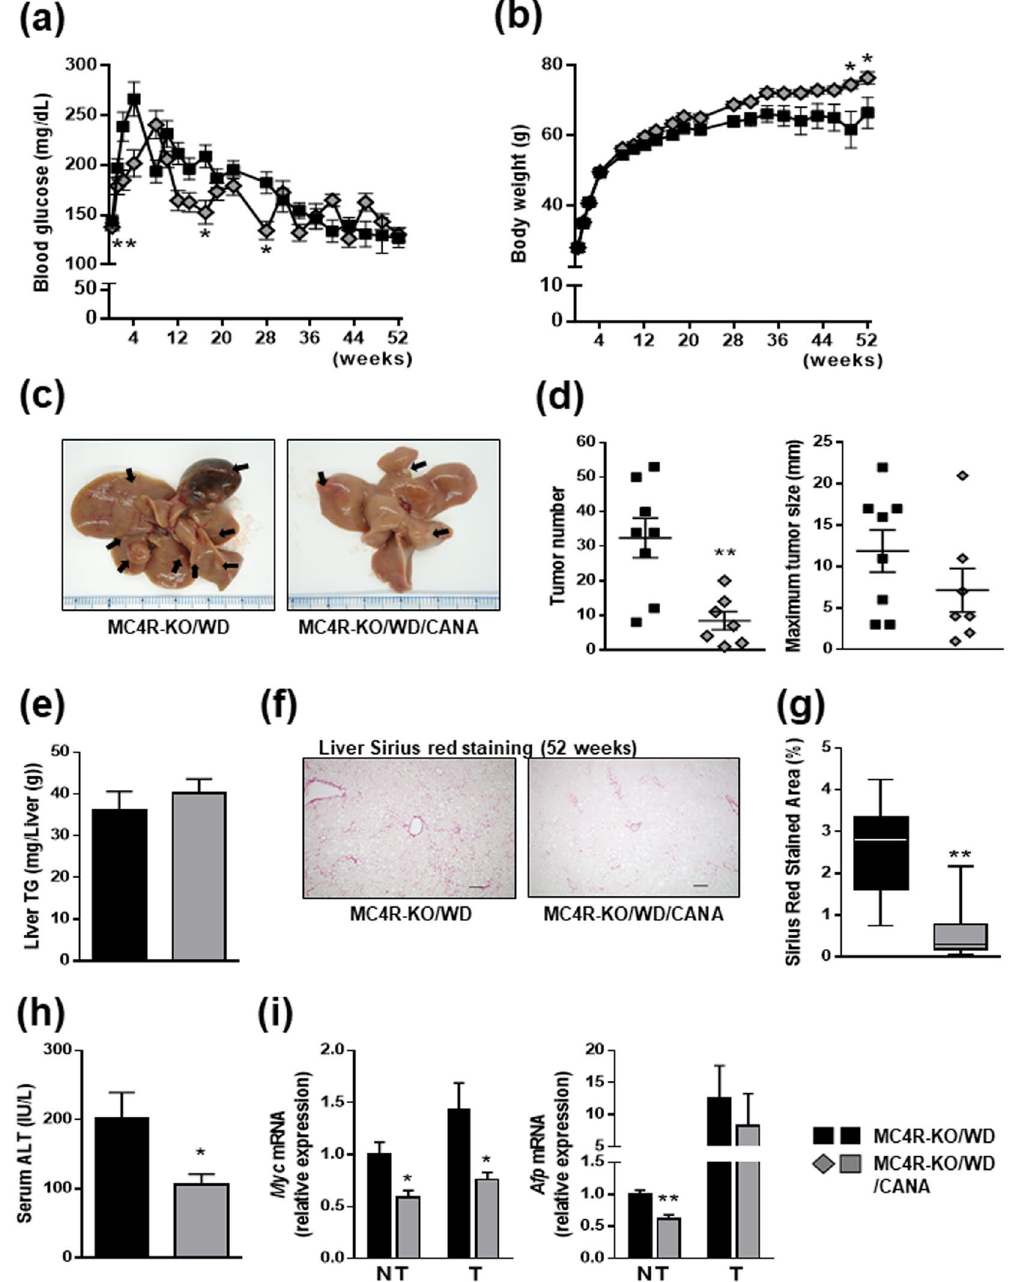
Figure 5. CANA attenuates the development to hepatocellular carcinoma in WD-fed MC4R-KO mice. The changes in ( a ) blood glucose levels and ( b ) body weight during CANA treatment for 52 weeks. n = 8–9. ( c ) Representative images of livers. Arrows indicate tumors. ( d ) Tumor numbers and maximum size. ( e ) Triglyceride content of the liver tissues from non-tumor sites. ( f ) Sirius red staining of the liver sections and ( g ) quantification. ( h ) Serum ALT levels. ( i ) Expression levels of Myc and Afp genes in the liver tissues from non-tumor (NT) or tumor (T) sites. Original magnification, × 100. Scale bars, 100 μ m. * p < 0.05, ** p < 0.01 vs MC4R-KO/WD. Statistical analyses were performed using non-paired Student’s t ( a , d , e , h and i ) or Mann-Whitney ( g ) test. n =